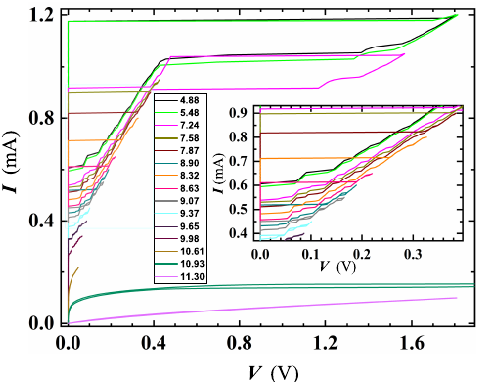
Figure 10. I-V characteristics for the SR5 film, carried out at several T . Both up- and down-current sweeps evidence the presence of slanted steps due to the occurrence of intermediate resistive regimes before the complete transition to the normal state. Inset: magnification of the central part of the